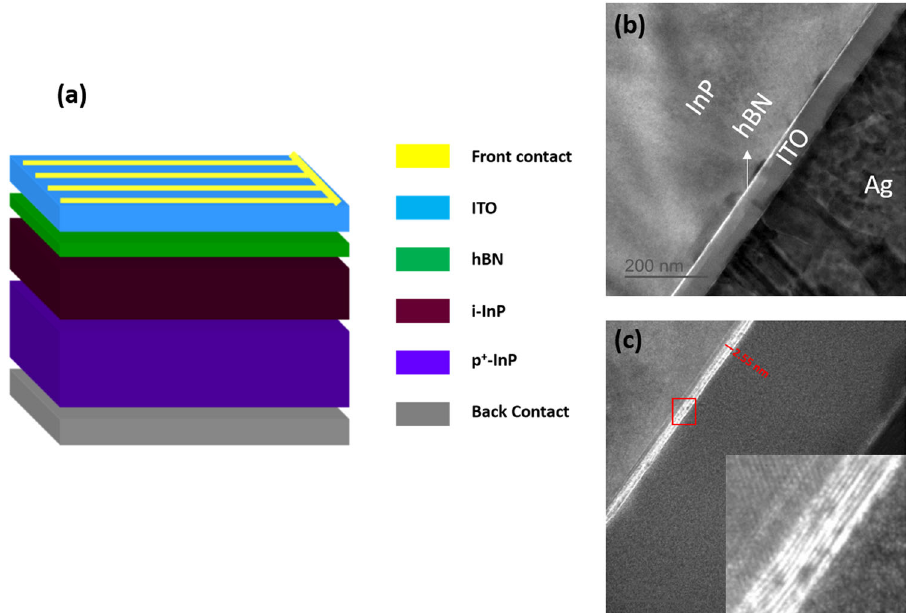
Fig. 2 3D schematic and TEM of device structure. a A schematic showing different layers of the solar cell. b A cross-sectional transmission electron microscope (TEM) image of the solar cell showing the different layers (scale bar: 200 nm). c A magni fi ed TEM image showing 2.55-nm thick hBN sandwiched between ITO and i-InP (scale bar: 20 nm). Inset shows the layered structure of